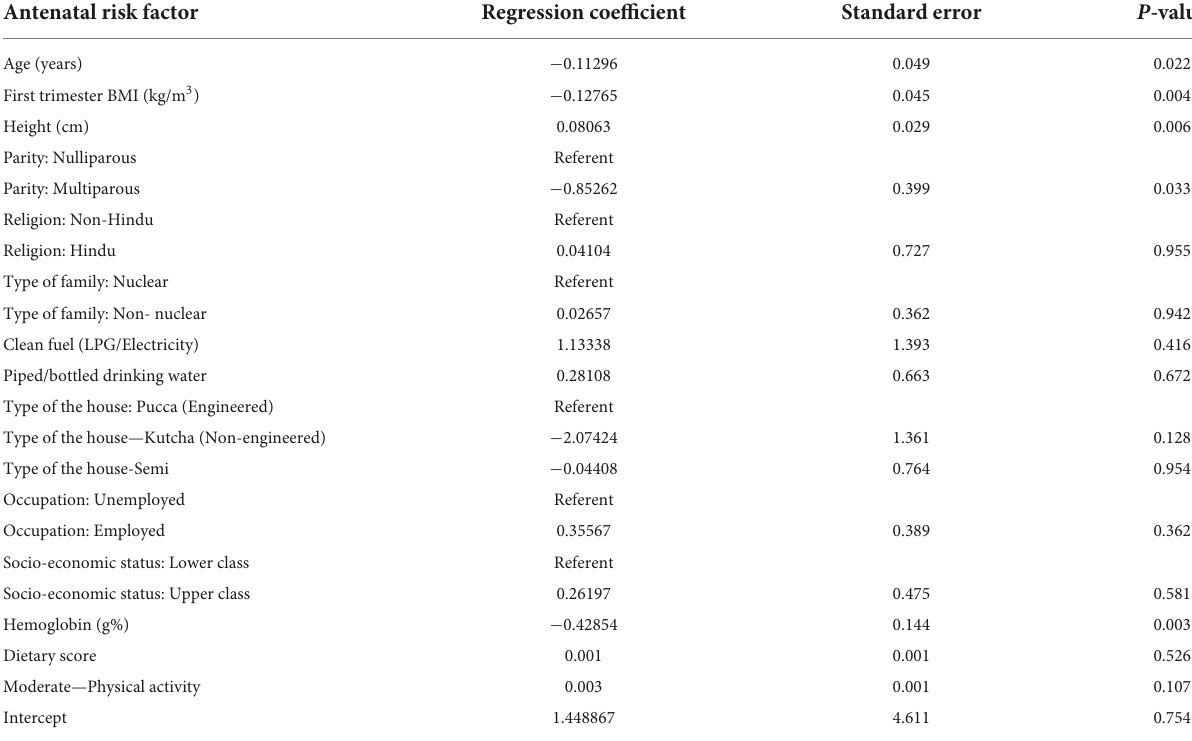
TABLE 5 Association between antenatal factors and total GWG evaluated in a multivariable regression analysis ( n = 640). Antenatal risk factor Regression coefficient Standard error P